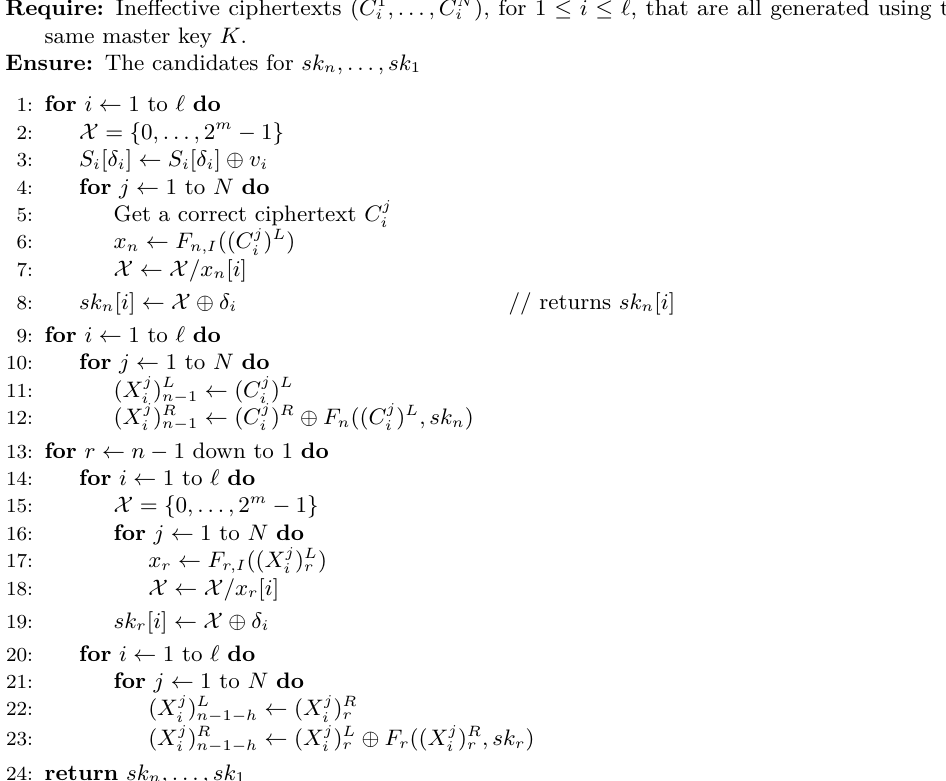
= ( C j ) L k ( C j ) i i i